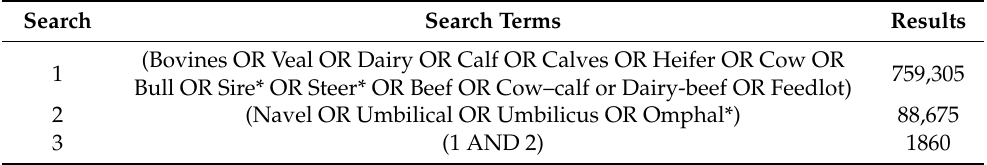
Table 1. Initial search results obtained from SCI-EXPANDED, CPCI-S, and ECSI (via Web of Science) conducted on 26 November